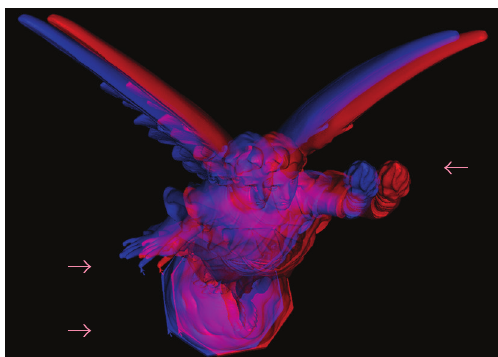
Figure 2: Lucy red-blue stereo pair with three samples of stereo mouse cursor presented at di ff erent distances